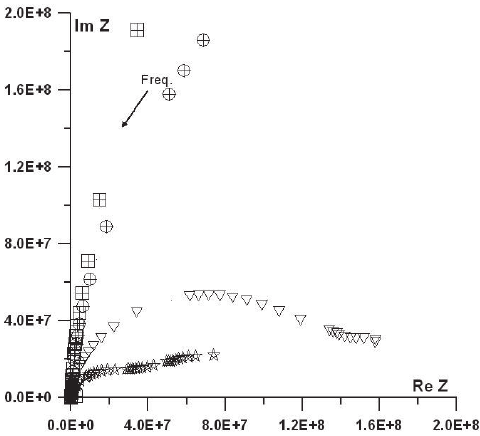
Fig. 6. The complex resistivity plane representation of the sample for relative saturations 18% ( ), 25% ( ),